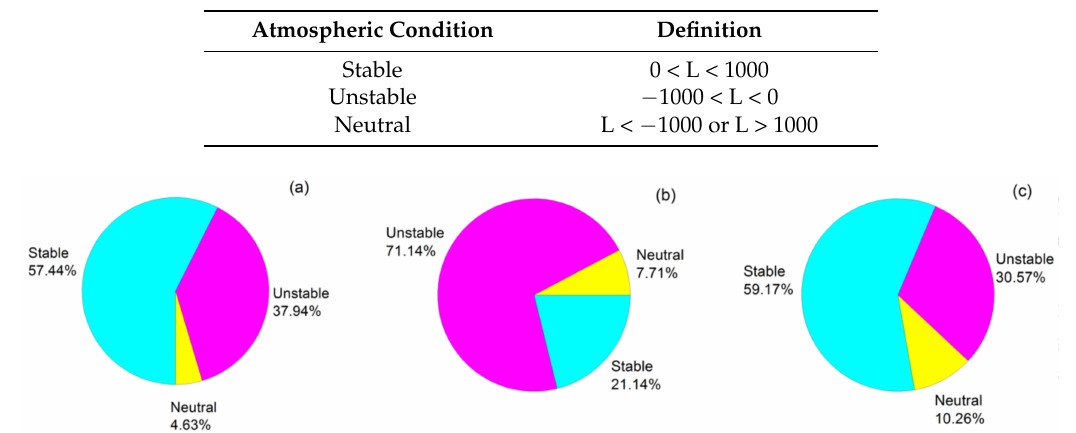
Table 6. Classification of atmospheric stability.